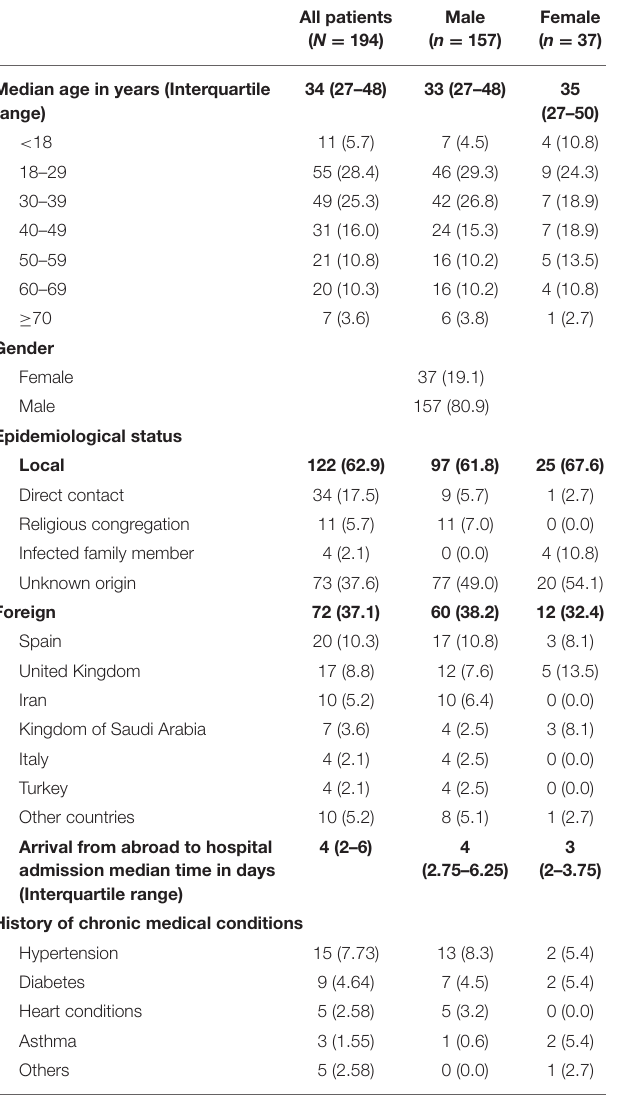
TABLE 1 | Demographical and epidemiological status of the patients ( N = 194).